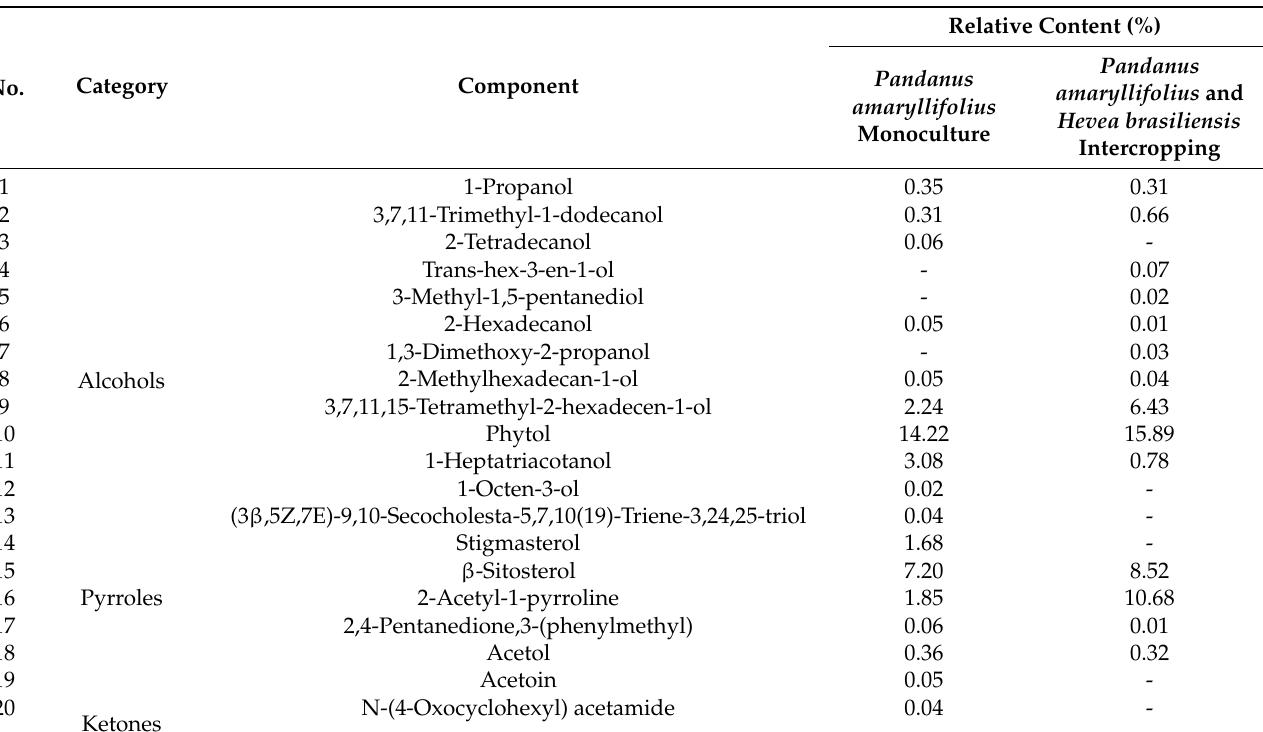
Table A1. The relative contents of volatile substances in different